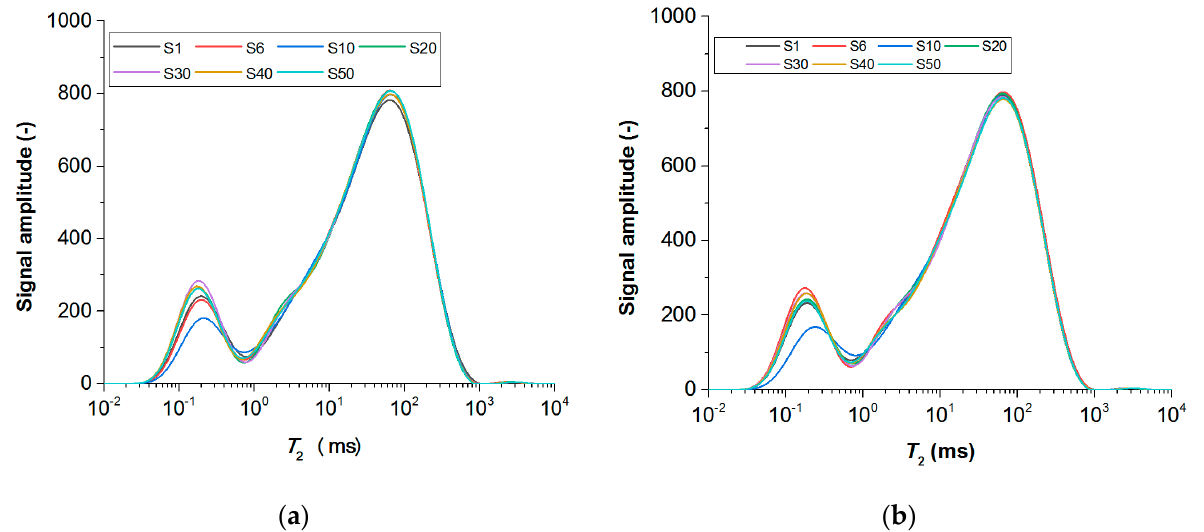
Figure 10. Variation curve of T 2 spectrum under two types of pore pressure after different cycles of fluid injection and production ( a ) 25 MPa; ( b )10 MPa.